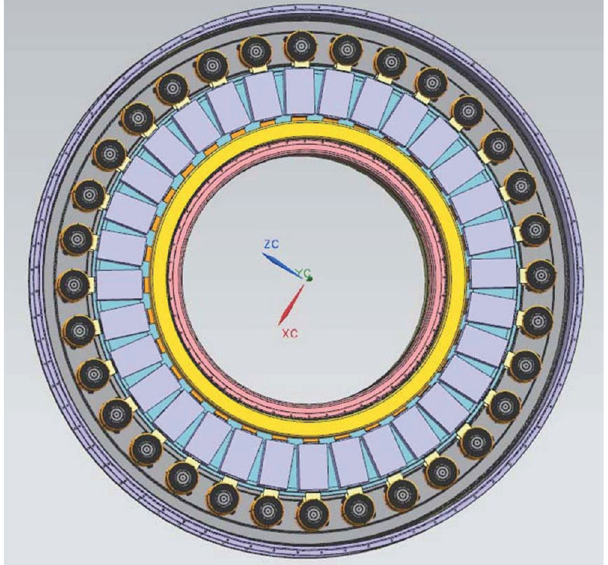
FIG. 7. Schematic of the LTD layout in M-50. The top flange was removed to show the inside. The 32 bricks were placed in spoke manner. Magnetic cores (yellow ring) prevent current losing to the ground but to secondary of the